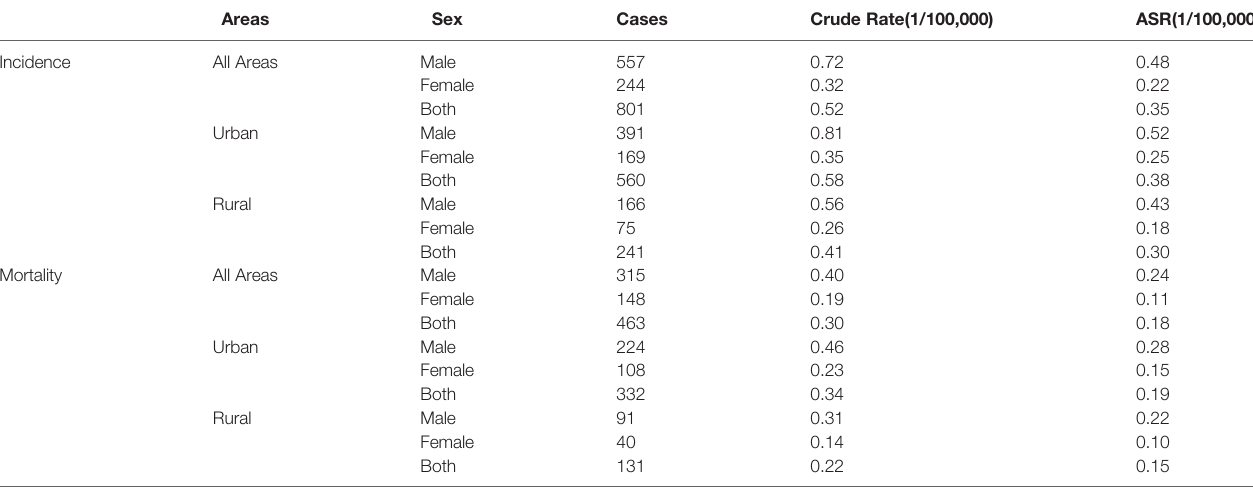
TABLE 2 | Incidence and mortality of peripheral T-cell lymphoma in Beijing from 2007 to 2018. Areas